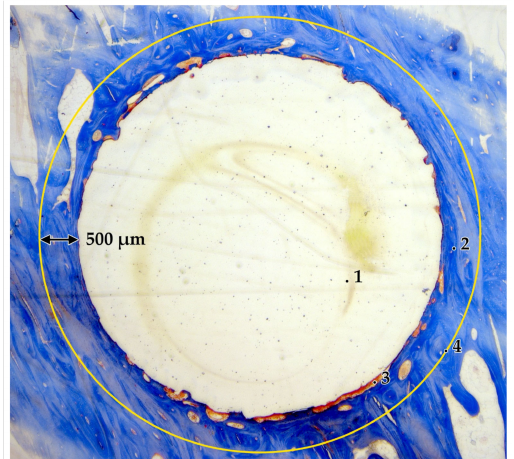
Figure 9. Masson-Goldner stained undecalcified section; (1: biomaterial, 2: bone, 3: soft tissue, 4: ROI 500 µ m (yellow circle)).